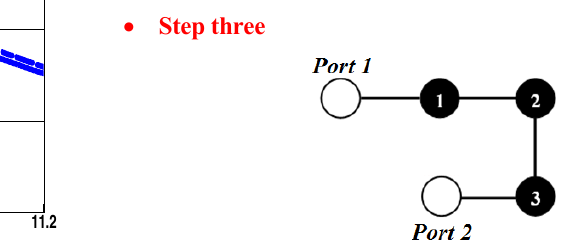
FIGURE 7. Step two: EM response of tuned results (solid lines) and target results (dashed lines).